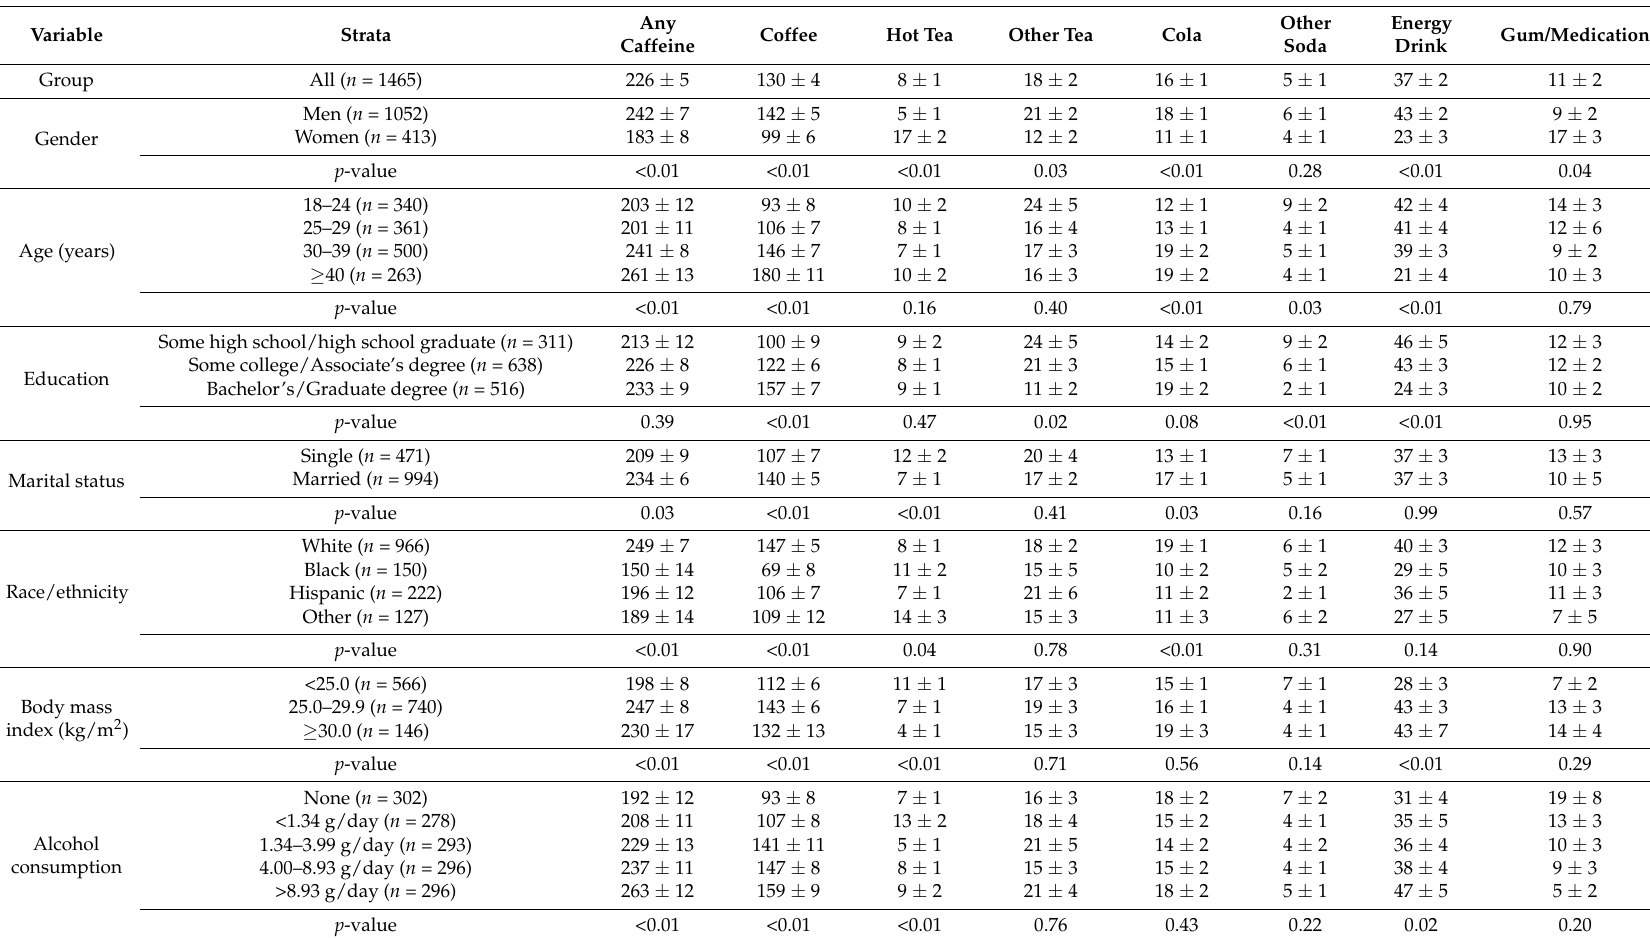
Table 3. Caffeine consumption (mean ± SE mg/day) among Navy and Marine Corps consumers ( ≥ 1 time/week) by demographic, lifestyle, and military characteristics. ( p -values are from one-way analysis of